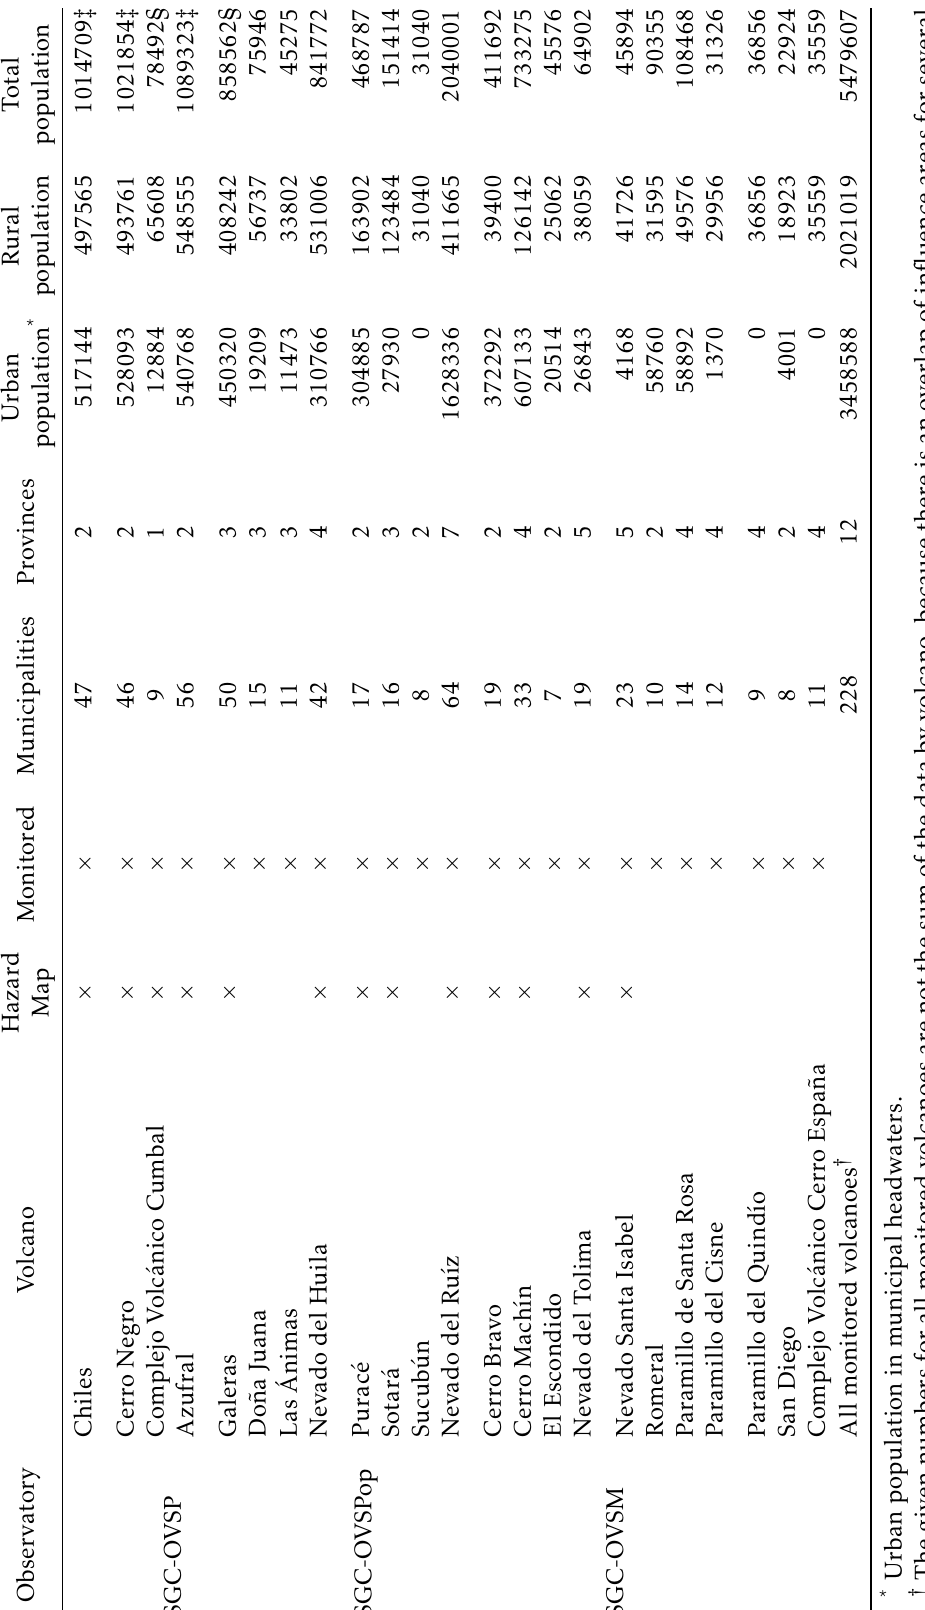
Table 2: The cities and population exposed to volcanic hazards at relevant active Colombian volcanoes. The population information is based on the 2018 census, conducted by the Departamento Administrativo Nacional de Estadísticas (DANE) and available via the link